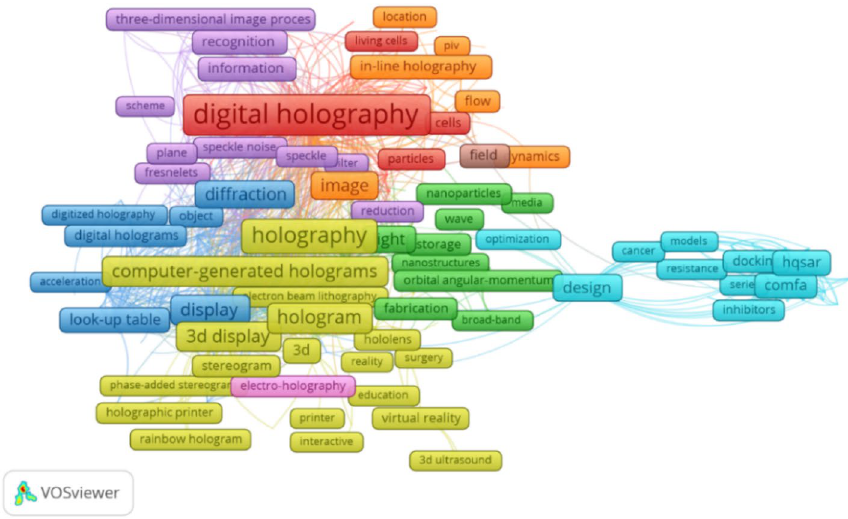
Figure 8. Analysis of keywords in the VOSviewer program (Holo-SDK 1.0 in Unity, https:// www. holo- sdk. com/) for the keyword “Hologram 3D”. Source own study.